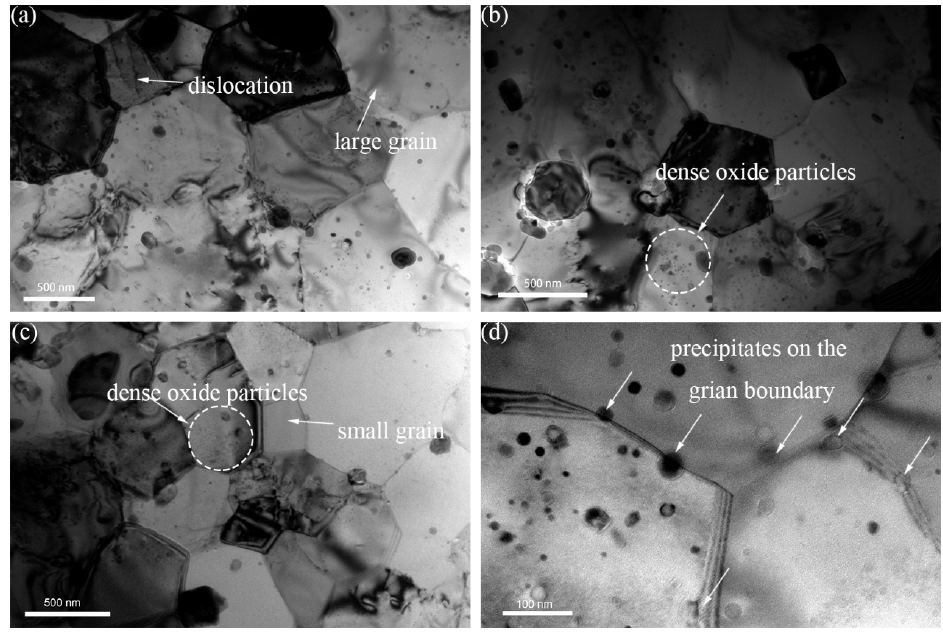
Figure 1. TEM images of microstructure/substructure in: ( a ) 16Cr ODS; ( b ) 16Cr-0.3Zr ODS; and ( c ) 16Cr-0.6Zr ODS steels; and ( d ) precipitates on the grain boundary of 16Cr-0.6Zr ODS steel.